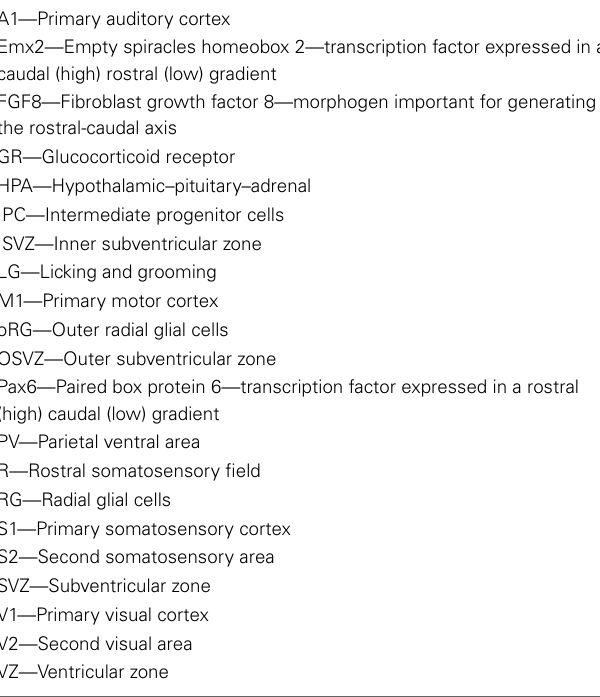
Table 1 | Abbreviations used throughout the